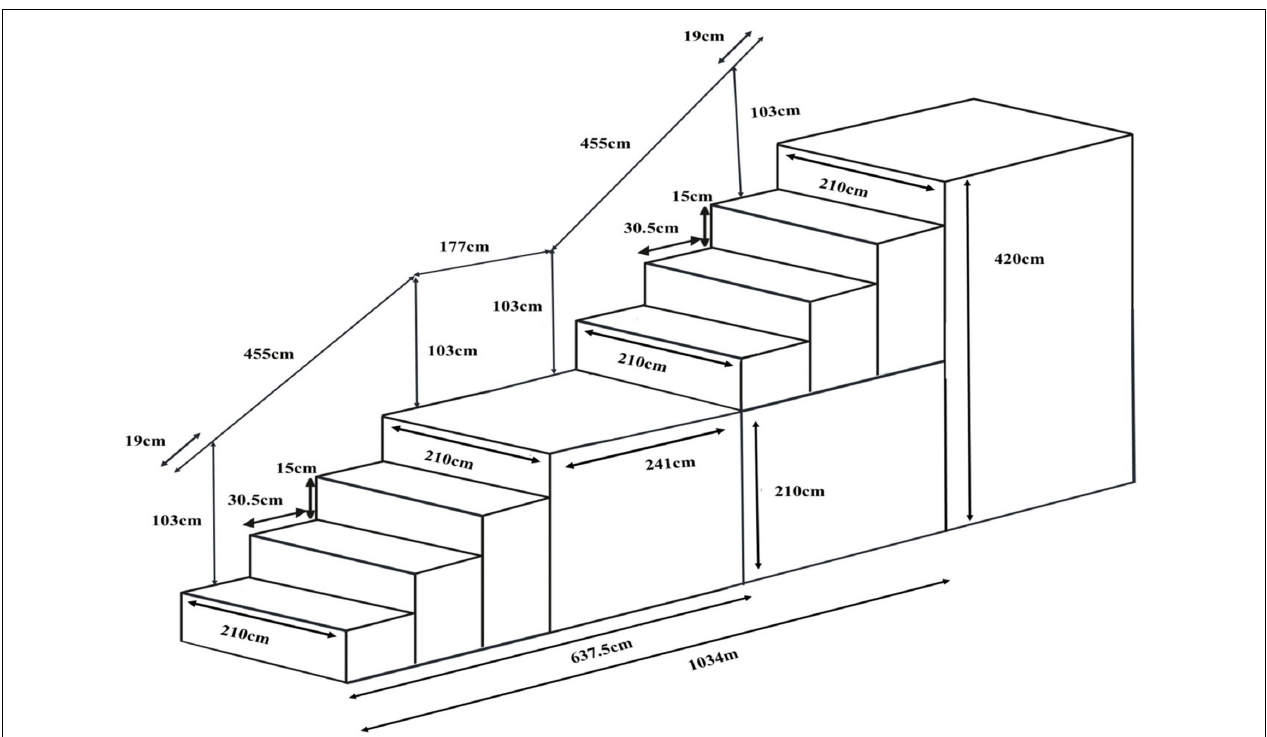
FIGURE 1 | Designated stairway where participants were observed and